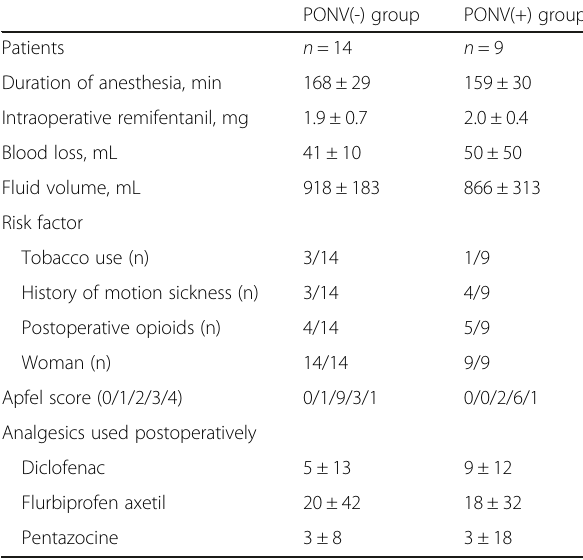
Table 2 Patient demographics